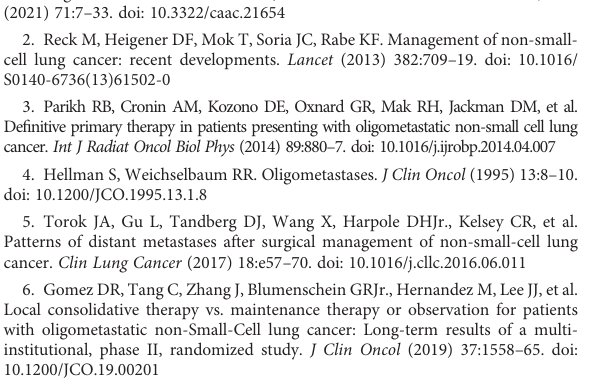
SUPPLEMENTARY FIGURE 1 Kaplan-Meier probability plots of Overall Survival and Cancer Speci fi c Survival between the Immunotherapy group and the No immunotherapy group within different metastatic site subgroups: BOM group (SEER: a and b; Single-Center: k and l), BRM group (SEER: c and d; Single-Center: m and n), LIM group (SEER: e and f; Single-Center: o and p), MOM group (SEER: g and h; Single-Center: q and r), and OTM group (SEER: i and j; Single-Center: s and t). Abbreviations : MOM, multiple organ metastases; OTM, other